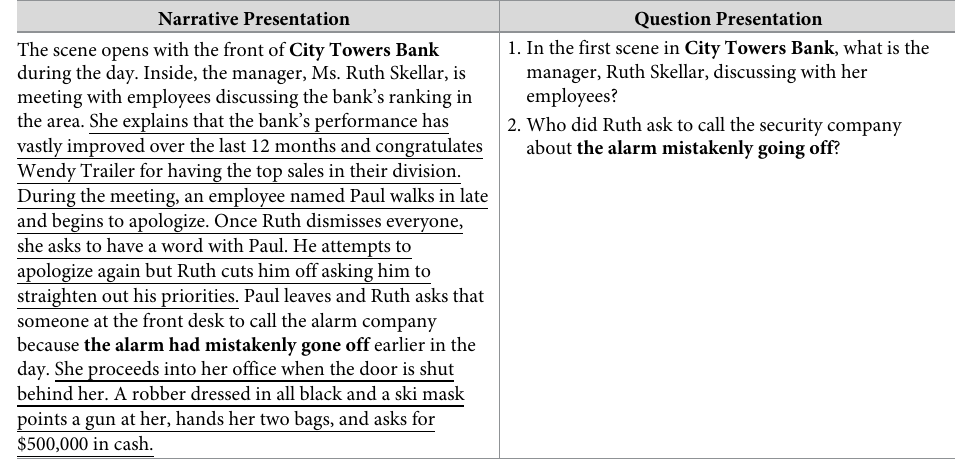
Table 1. An example of a narrative that contains contextual details compared to their corresponding misleading questions without contextual details. Narrative Presentation Question